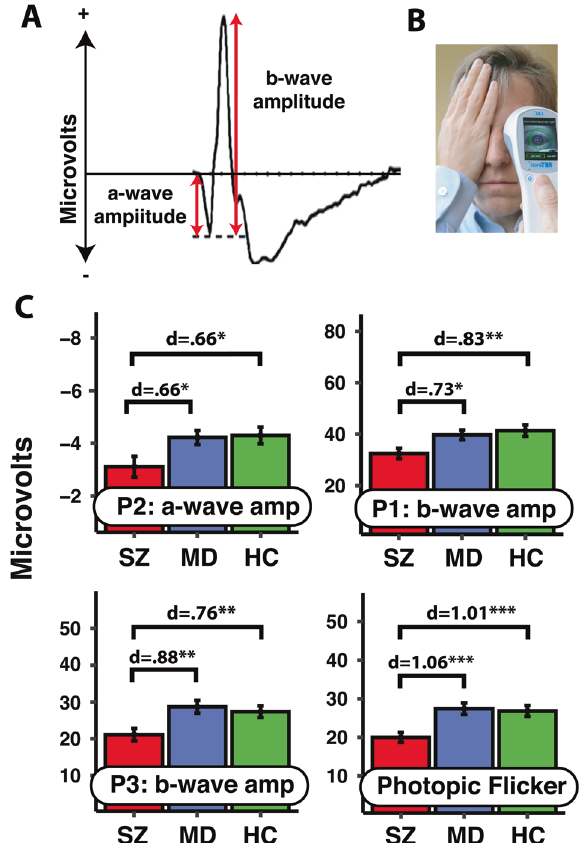
Fig. 3 Electroretinographic markers of early psychosis. A Two example waveforms that have distinguished schizophrenia patients from healthy controls and mood disorder patients (photopic fl icker response not shown). B Using a portable handheld device, light- adapted (photopic) retinal functioning of different cell types can be measured within 15 min. C Four ERG variables that have signi fi